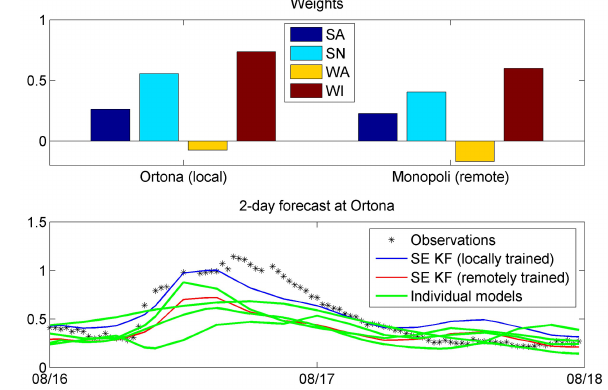
Fig. 7. Weights value computed at Monopoli and Ortona at the end of a 2-day hindcast (top panel) – Forecast of the individual models and the SE at Ortona with weights computed locally or remotely, i.e. at Monopoli (bottom